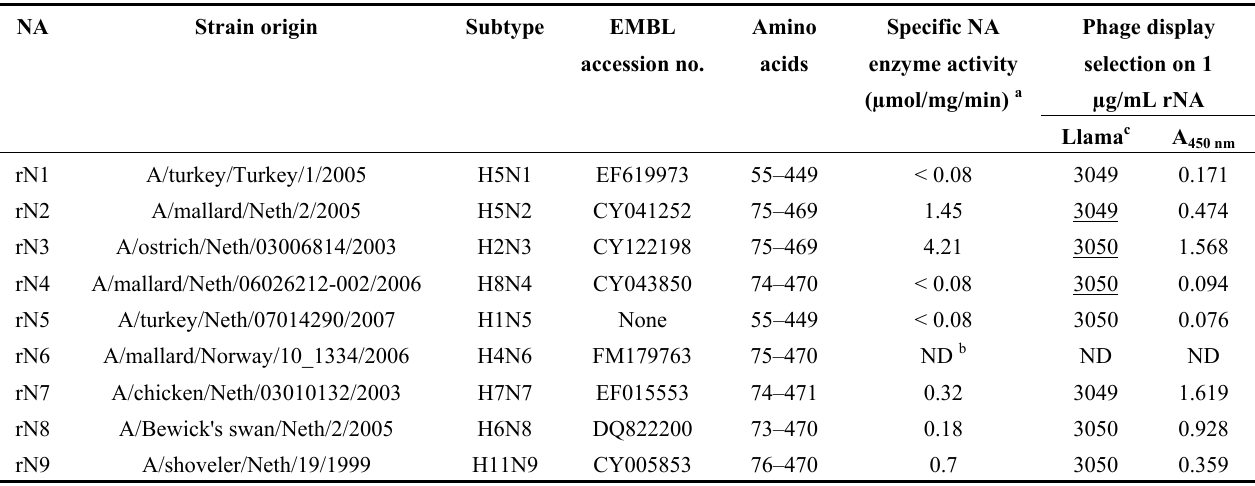
Table 3. Recombinant neuraminidase (NA) proteins